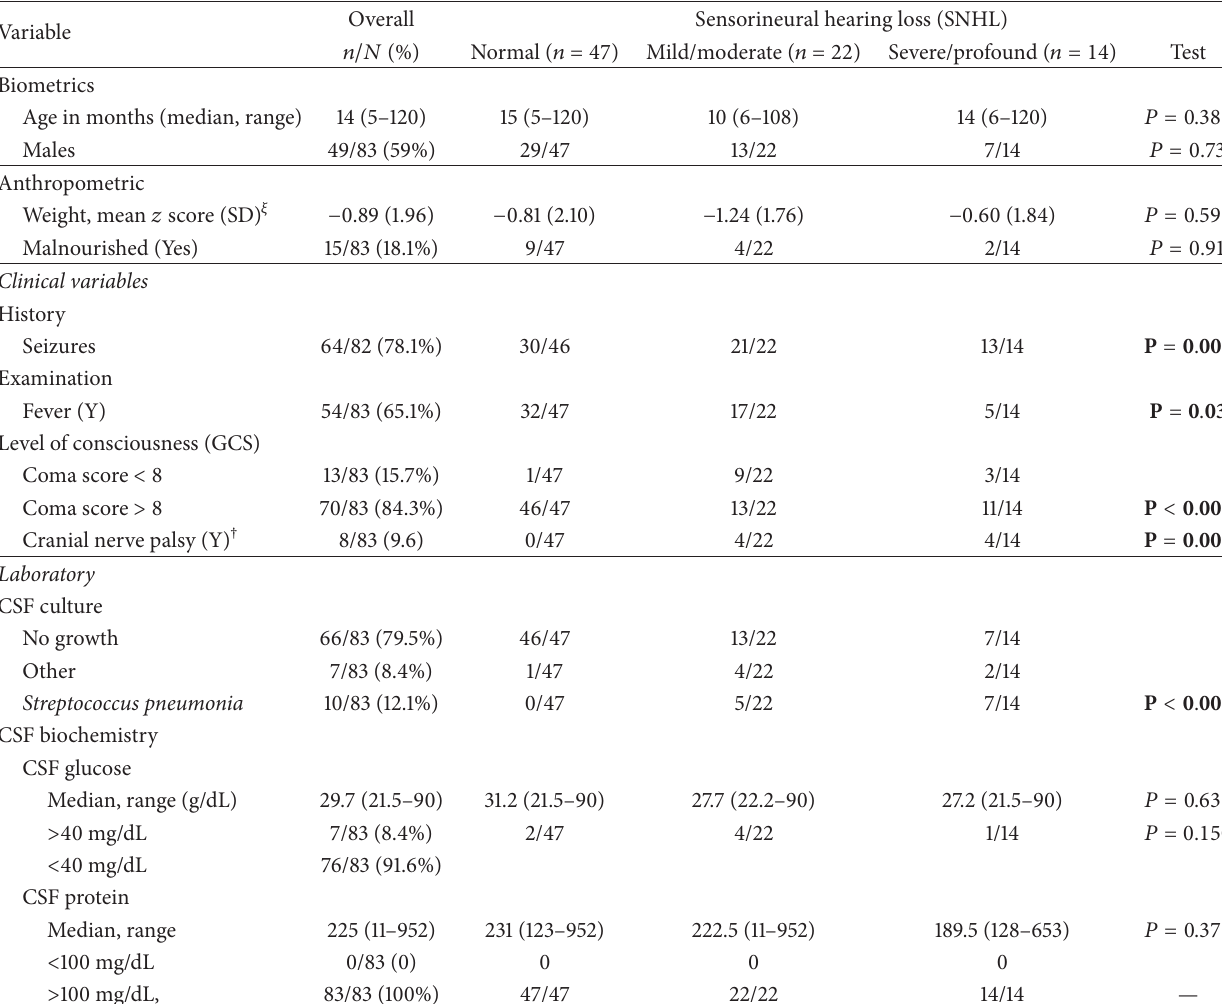
Table 2: Characteristics and findings in children with meningitis included in this study ( 𝑛 = 83 ).